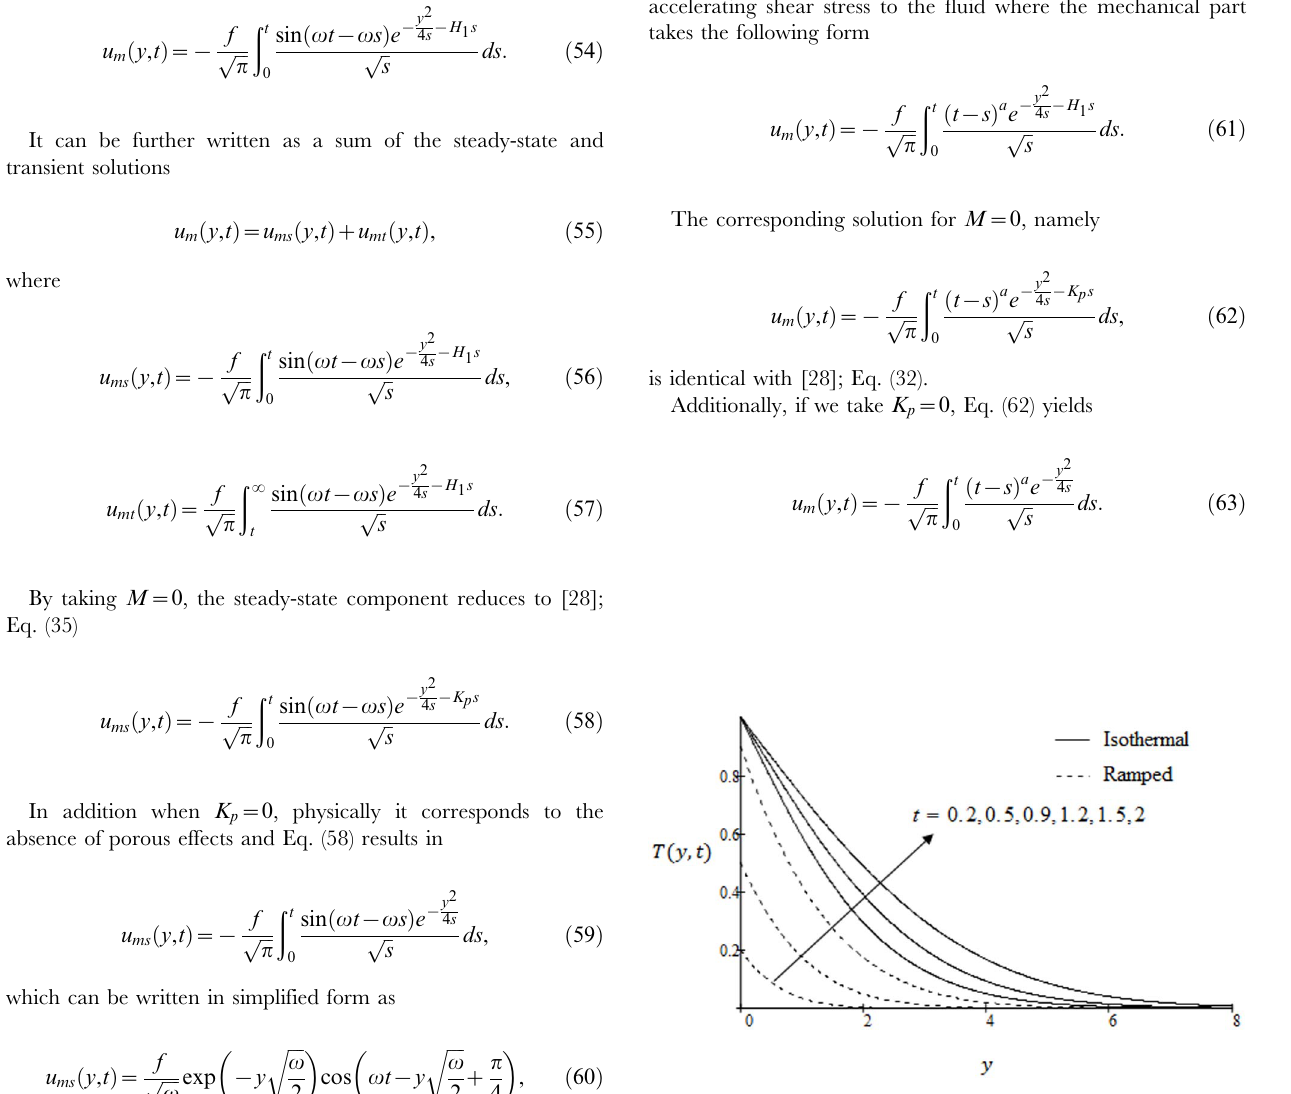
Figure 11. Temperature profiles for different values of t .